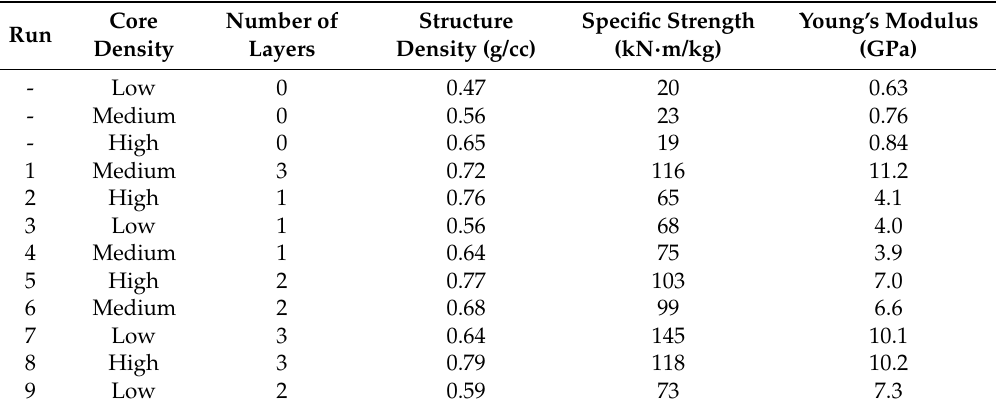
Table 4. Generated experimental matrix.